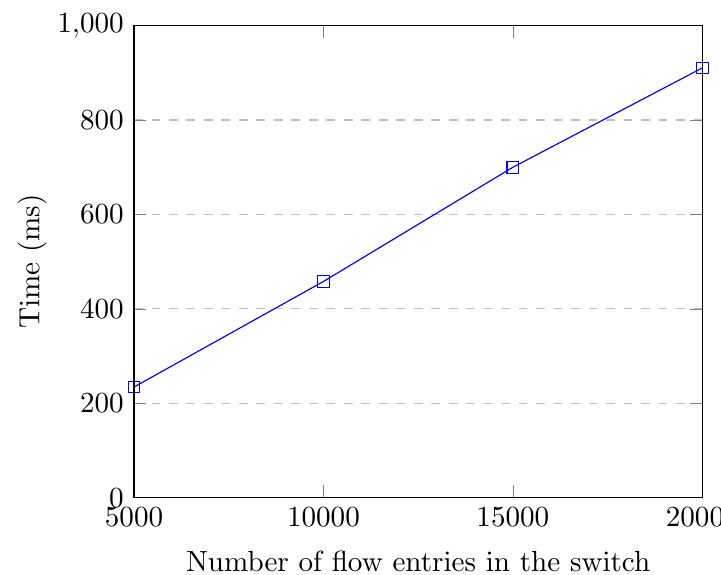
Figure 16. Feature retrieval time of 10 best features and classification up to 20,000 flow